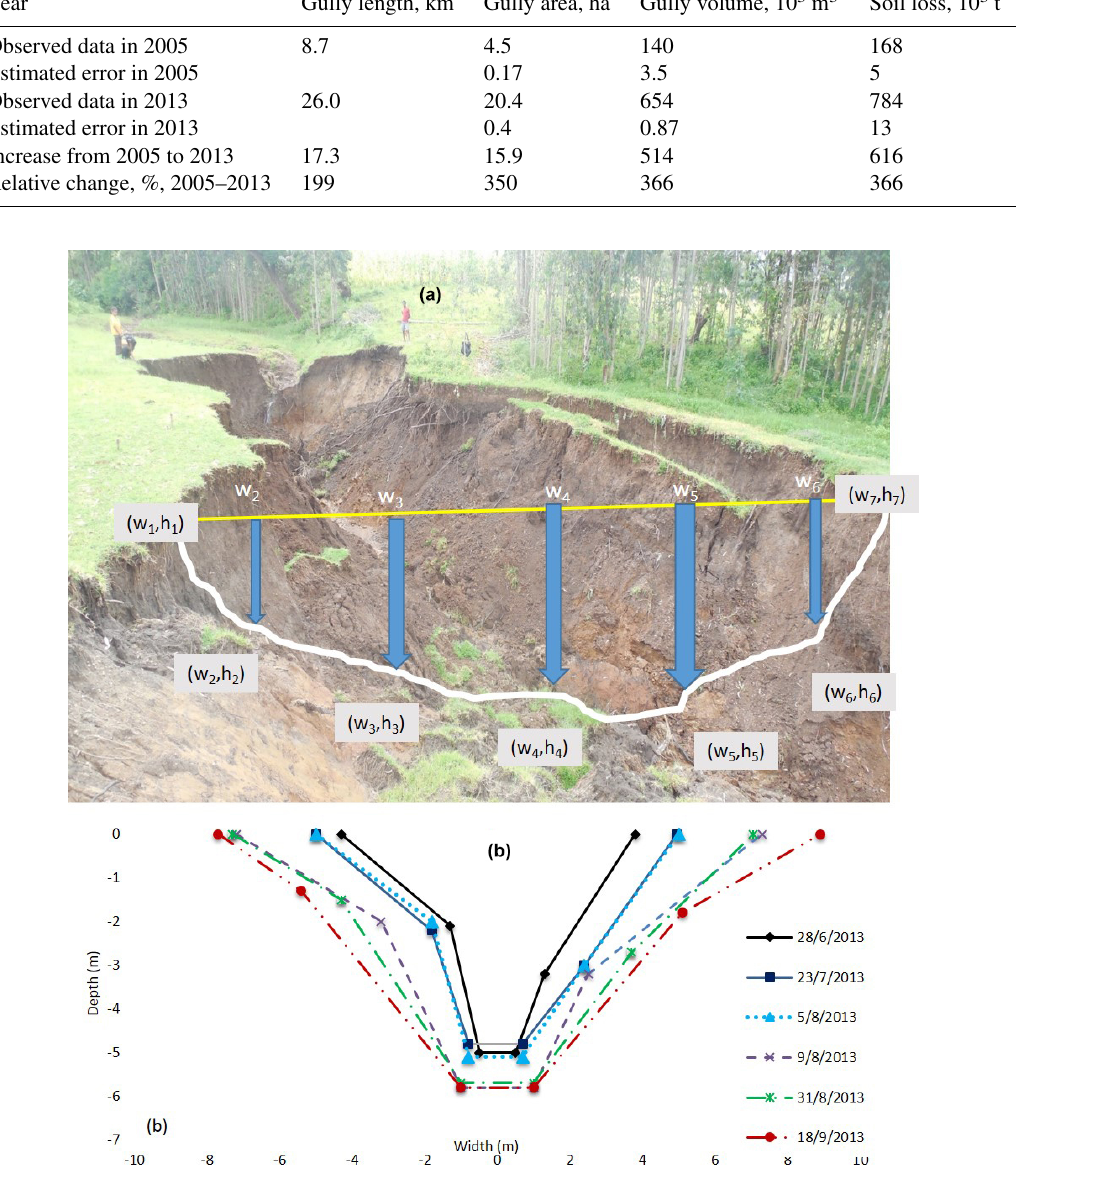
Figure 3. (a) Cross section segmentation methodology to determine the cross-sectional area of the gullies. (b) Measured profiles of a cross section located on gully G6 during the 2013 rain phase, showing the lateral and downward expansion of the gully.